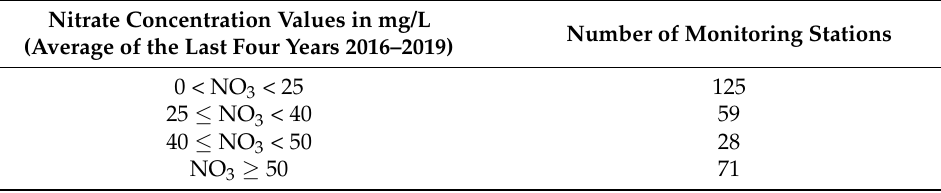
Table 5. Average nitrate concentration values per number of stations. Nitrate Concentration Values in mg/L (Average of the